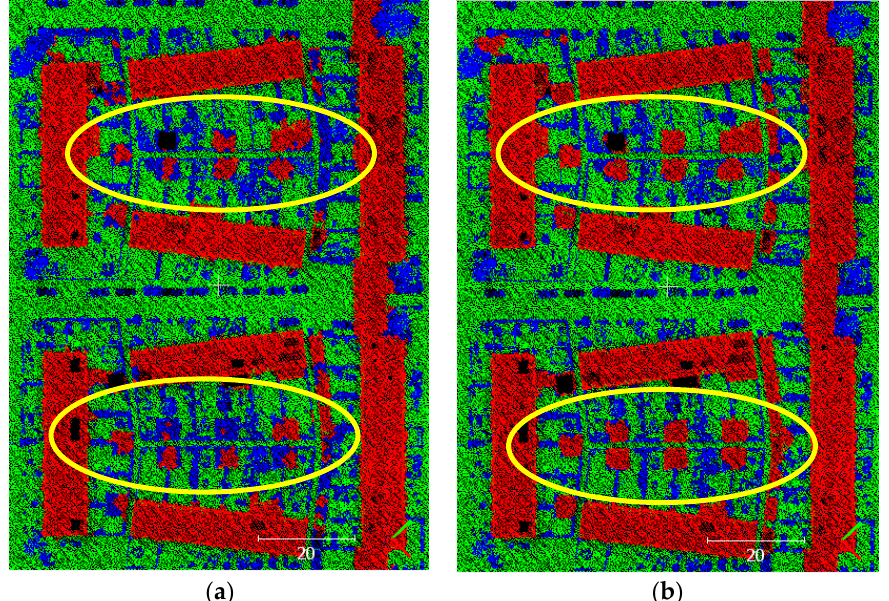
Figure 17. Difference between: ( a ) single pixel (1-m) MTN-FCN; ( b ): multi-scale MTN-FCN. Note the shape of the small building roofs.